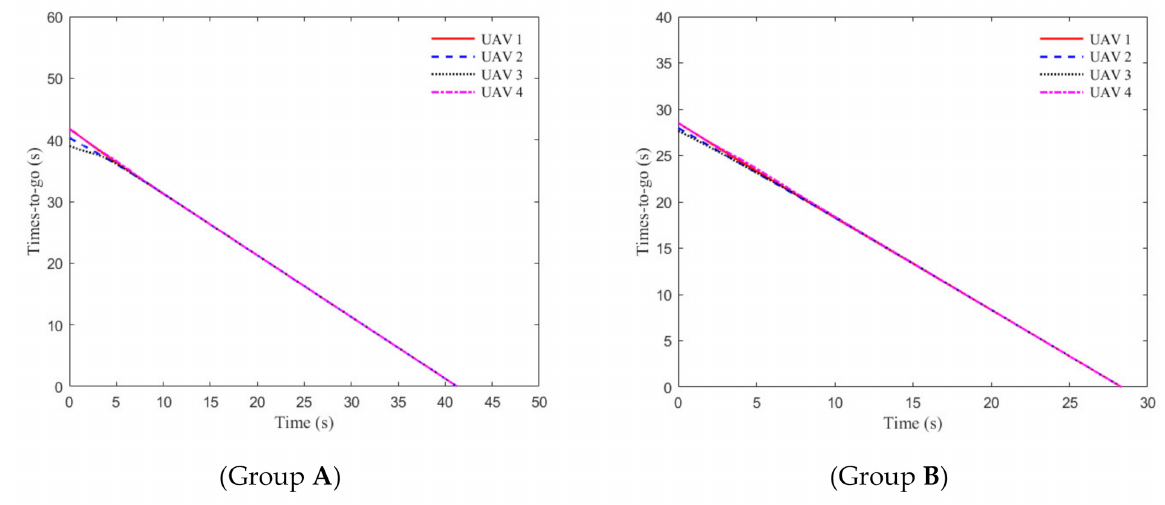
Figure 4. Time-to-go for four UAVs to attack a maneuvering